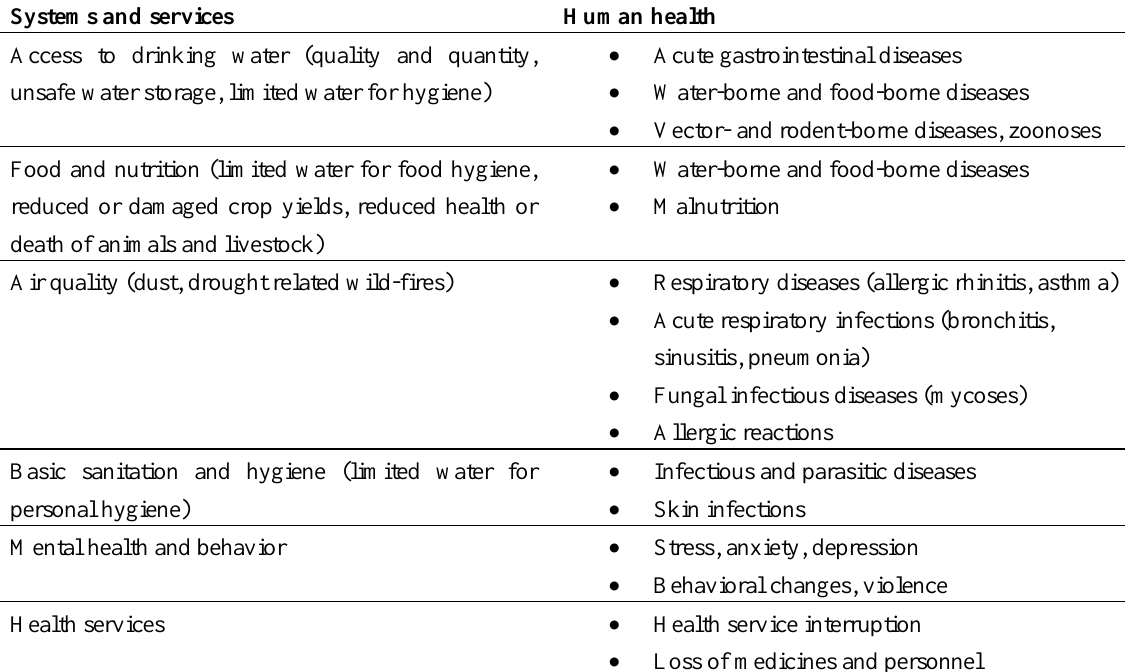
Table 1. Summary of relevant health conditions for the semiarid region in